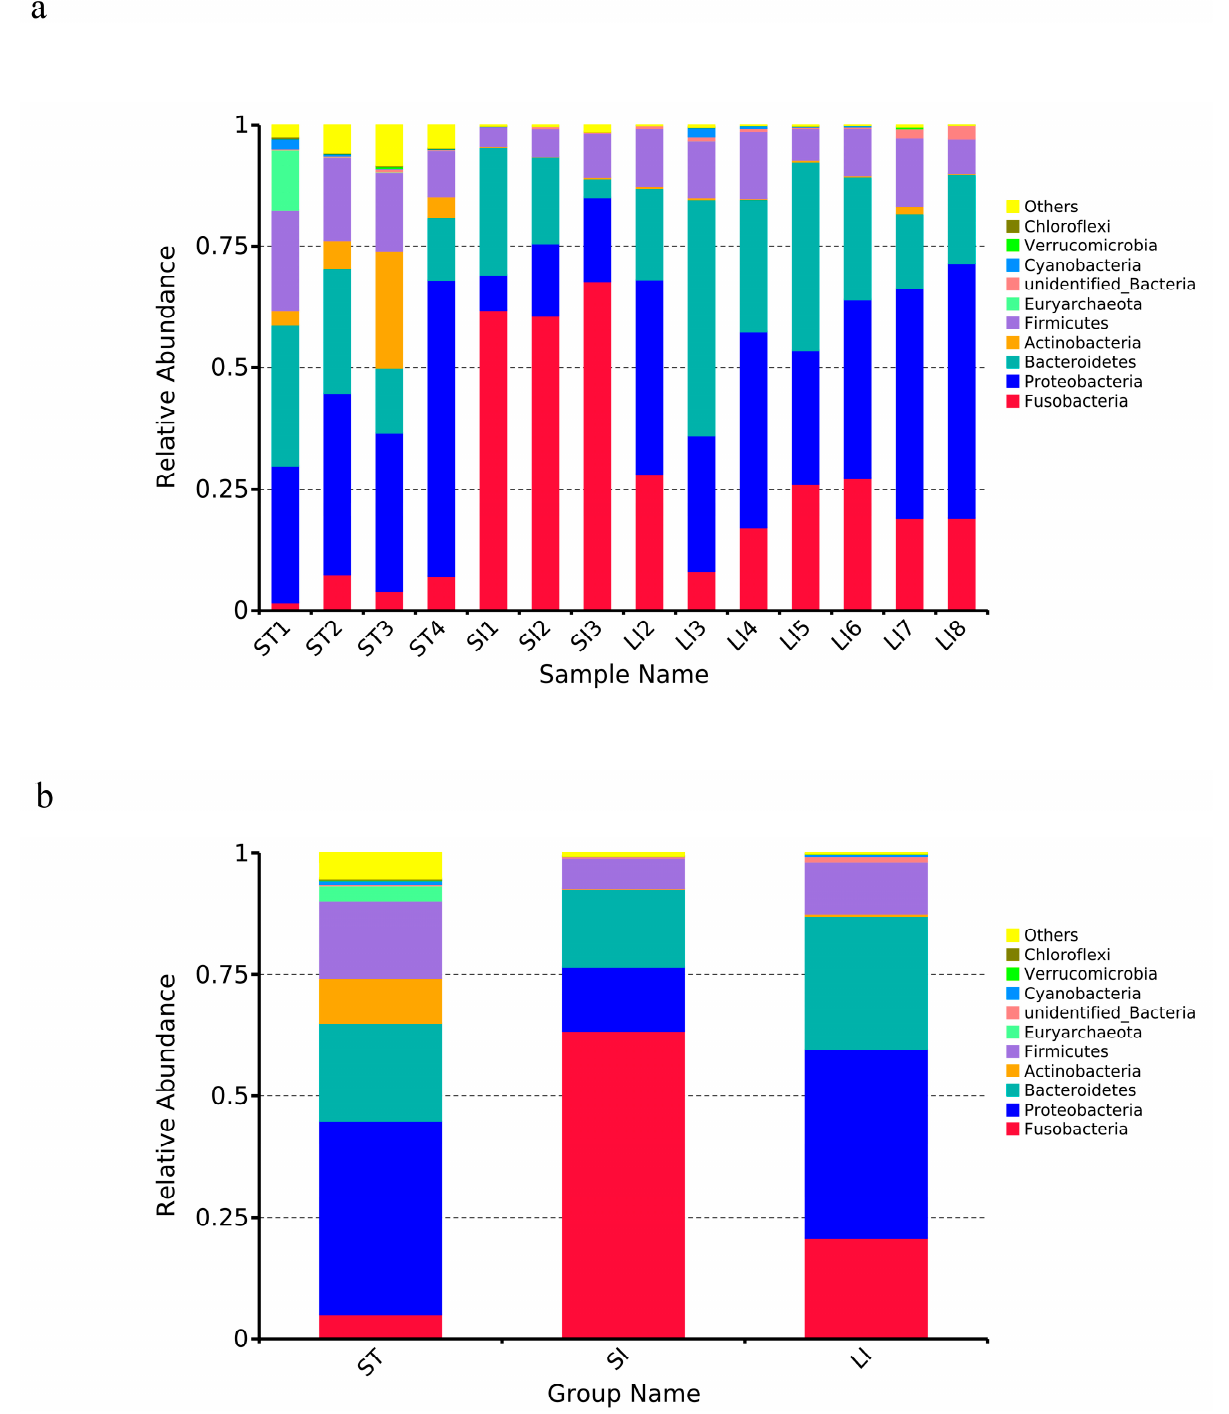
Figure 3. Microbial composition among the different samples ( a ) and segments ( b ) at the phylum level. The top 10 abundant taxa are shown. Abbreviations: LI, large intestine; SI, small intestine; ST, stomach.